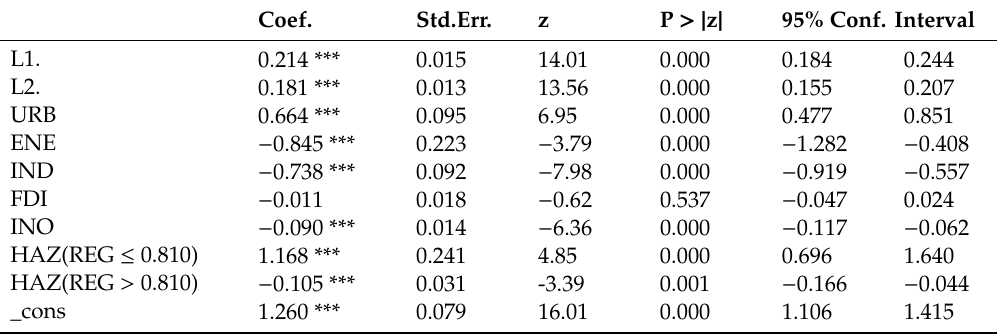
Table 4. Results of dynamic threshold